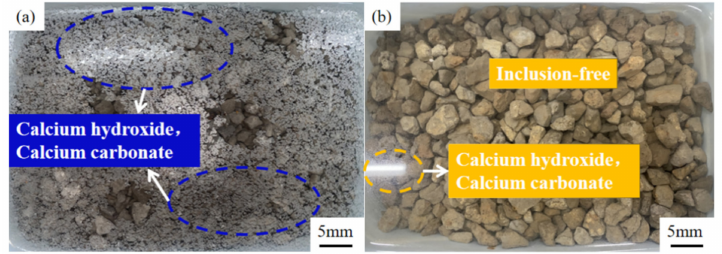
Figure 8. Water erosion process of untreated steel slag: ( a ) untreated; ( b )